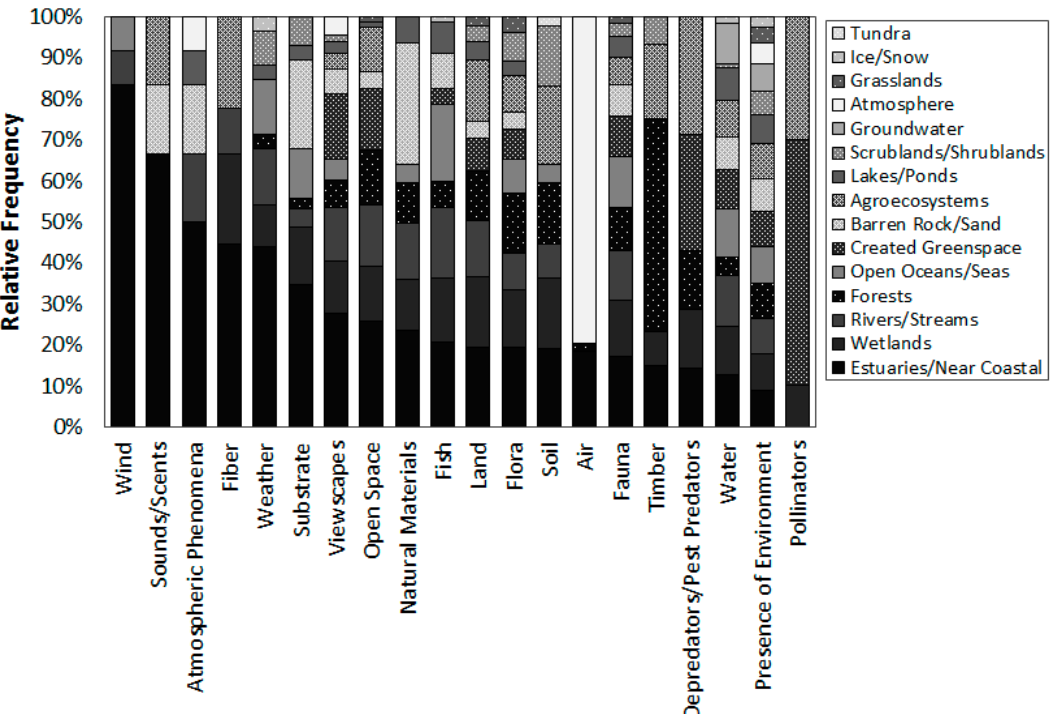
Figure 7. Relative frequency by which documents linked each type of FEGS to different types of Environments.